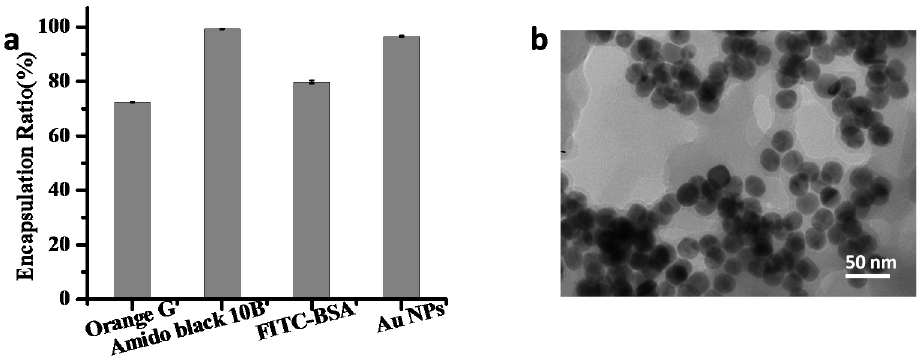
Figure 3. ( a ) The encapsulation ratios of different guests in the nano CPs; ( b ) the TEM image of the Au nanoparticles entrapped by Zn/adenine